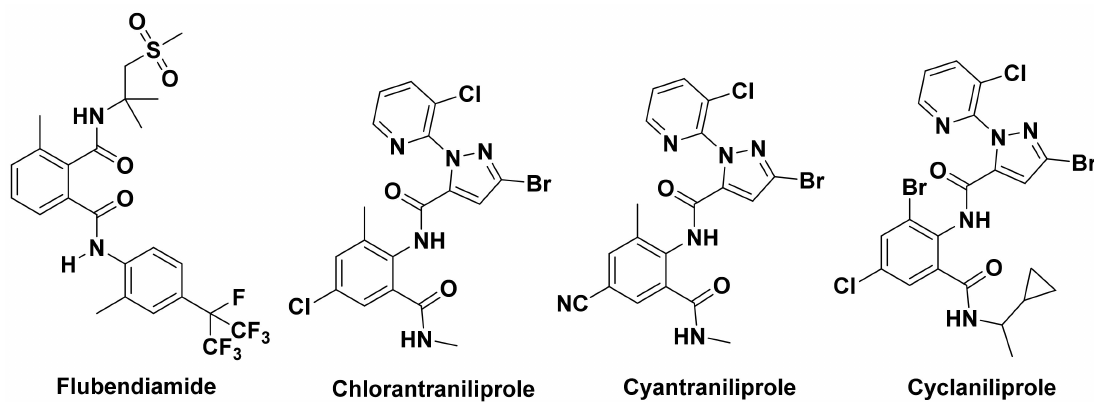
Figure 1. Chemical structures of flubendiamide, chlorantraniliprole, cyantraniliprole, and cyclaniliprole.